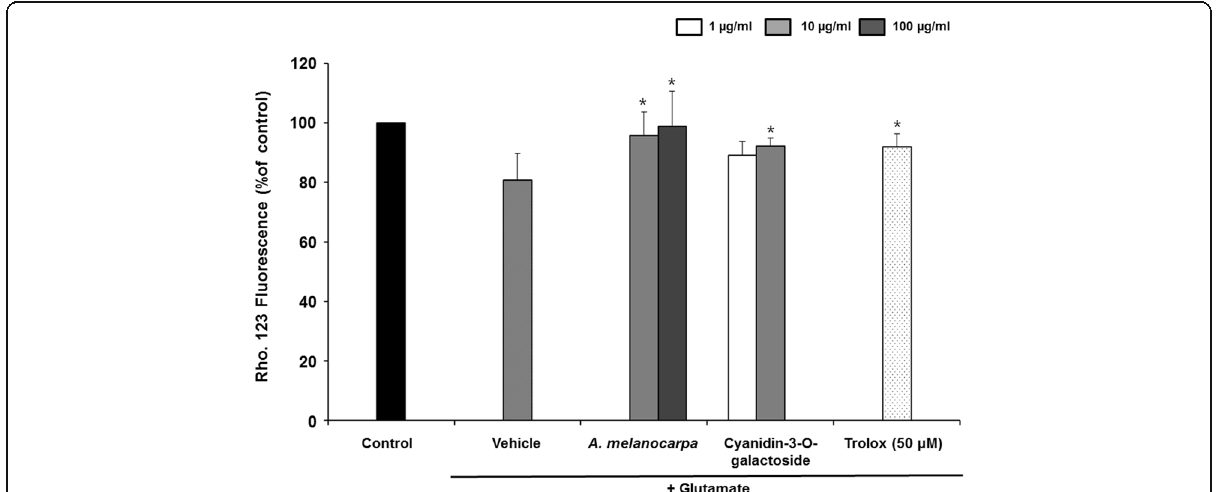
Fig. 4 Effect of A. melanocarpa extract (10 and 100 μ g/ml) and cyanidin-3-O-galactoside (1 and 10 μ g/ml) on glutamate-induced disruption of mitochondrial membrane potential. Data are means ± S.D. * p < 0.05 versus the glutamate-treated